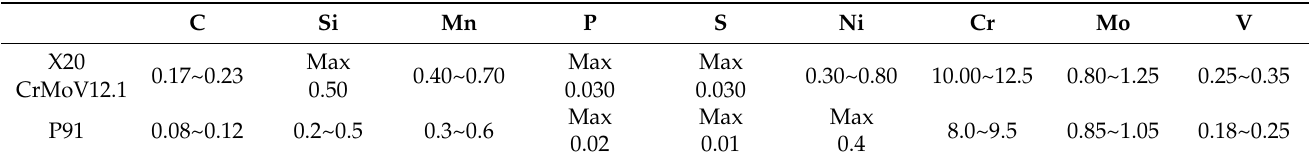
Table 1. Chemical composition (wt.%) of boiler